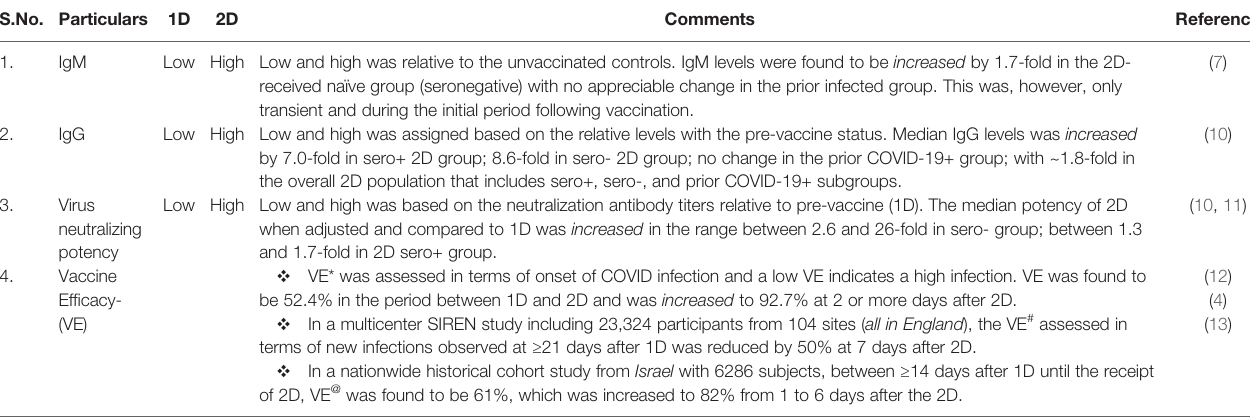
TABLE 1 | Some key responses and differences seen after 1D and 2D of COVID-19